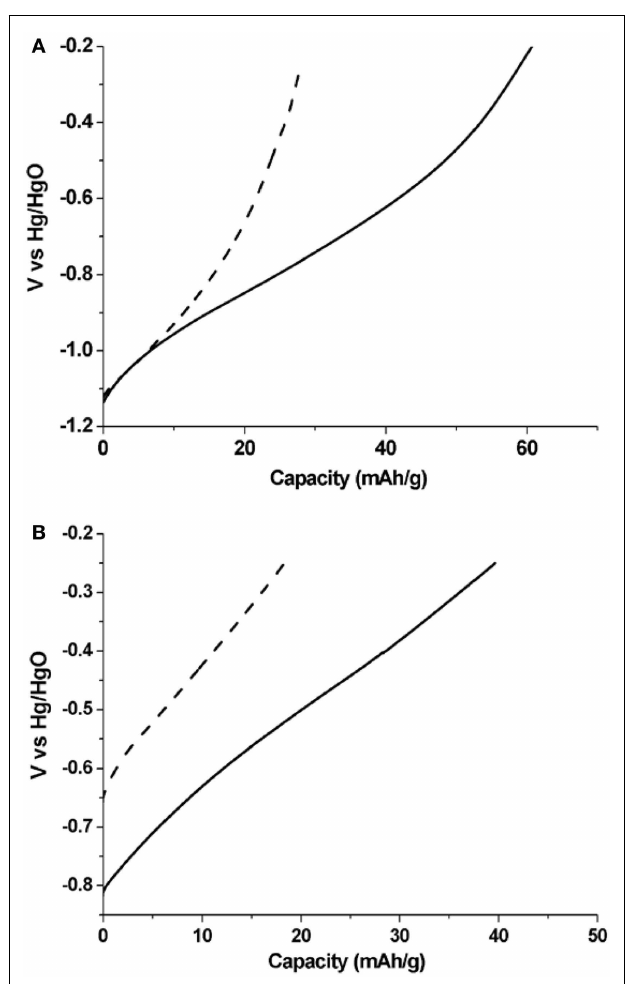
FIGURE 5 | (A) Discharge curves of HOMC (solid) and AC (dash) electrode after holding at constant potential of − 1.20V for 3h in 30 wt.% KOH solution. (B) Discharge current of both carbon electrodes after 48h resting at open circuit potential.